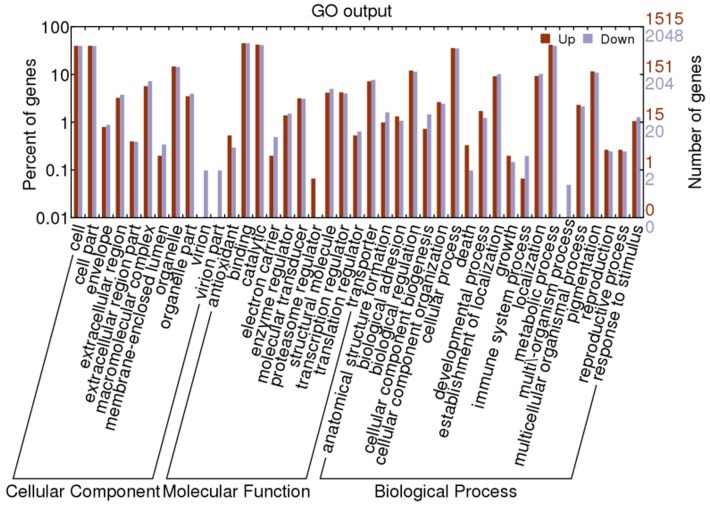
GO categories of predicted target genes of differentially expressed miRNAs at 96 h post-inoculation.